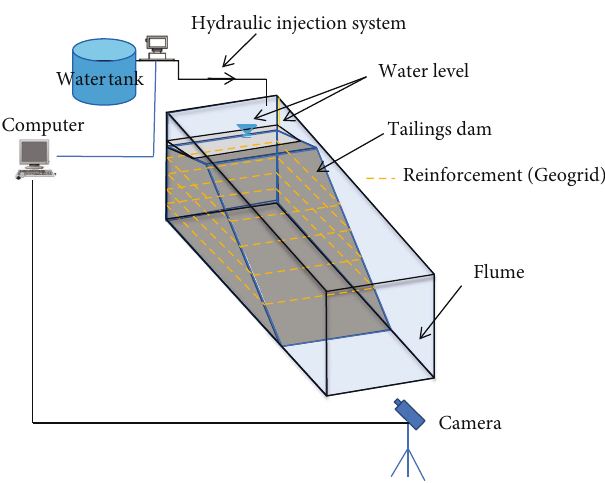
Figure 1: Tailings Dam Overtopping Failure Model Test System (TDOFMTS).